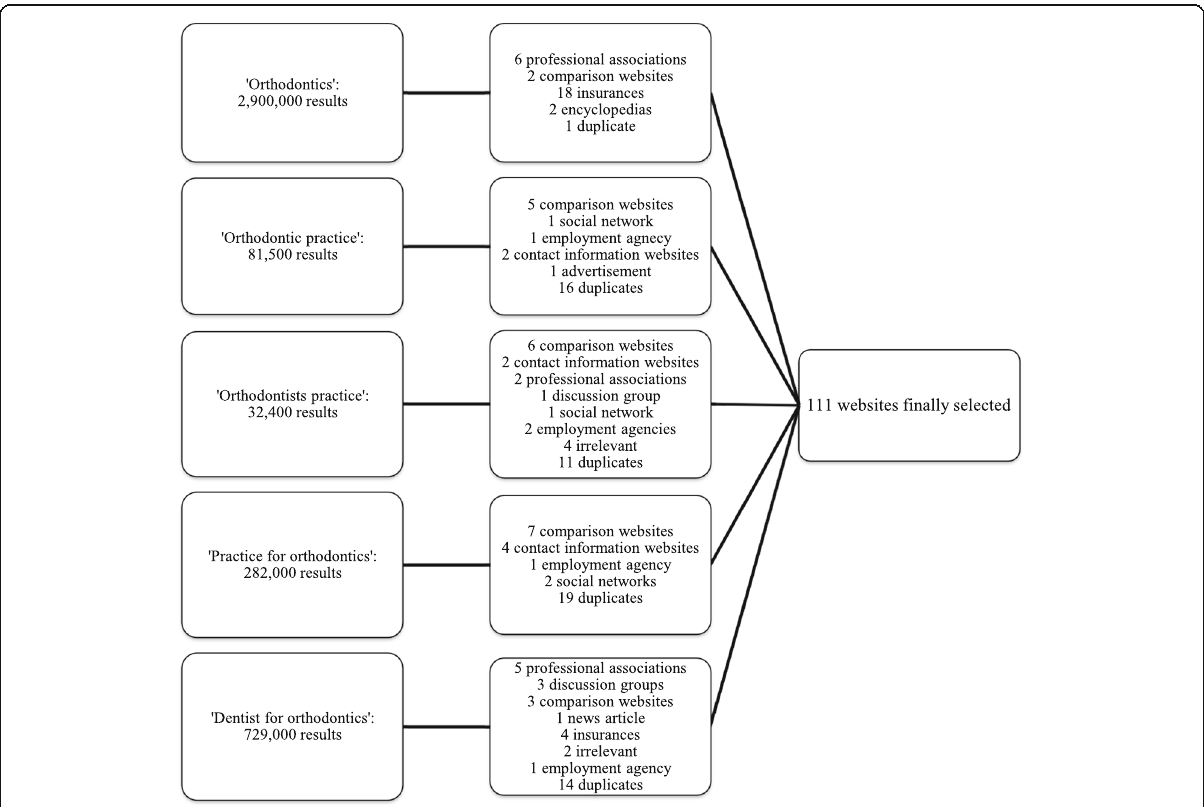
Fig. 1 Flowchart diagram of the selection